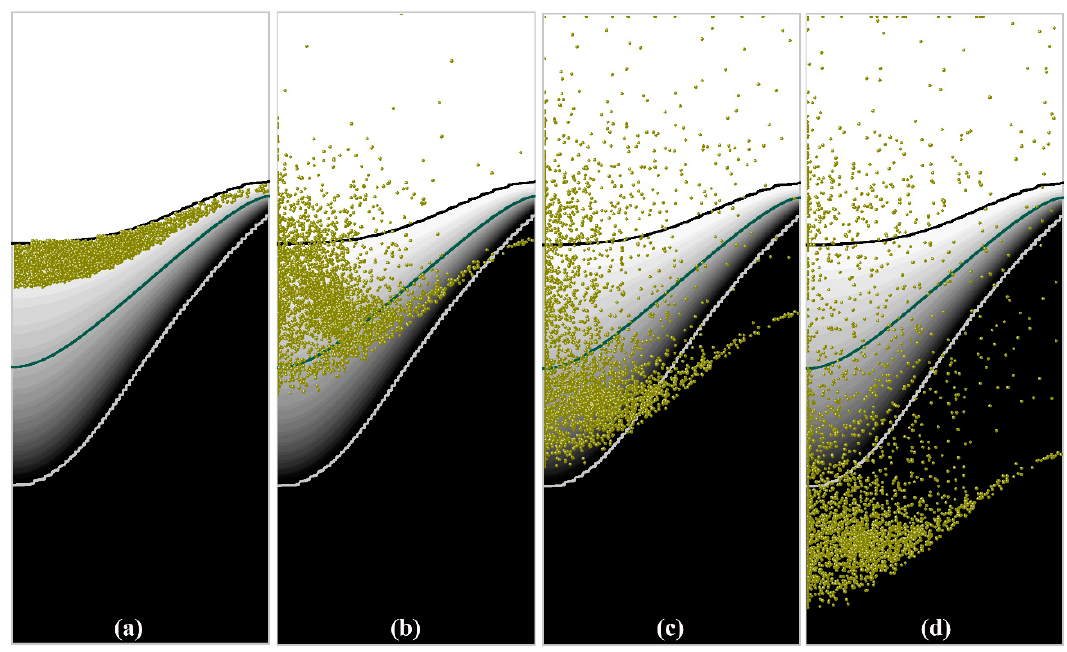
Figure 8. Simulated distribution of the grains in a solidifying DC casting, ( a ) 0 s, ( b ) 10 s, ( c ) 25 s, ( d ) 55 s.